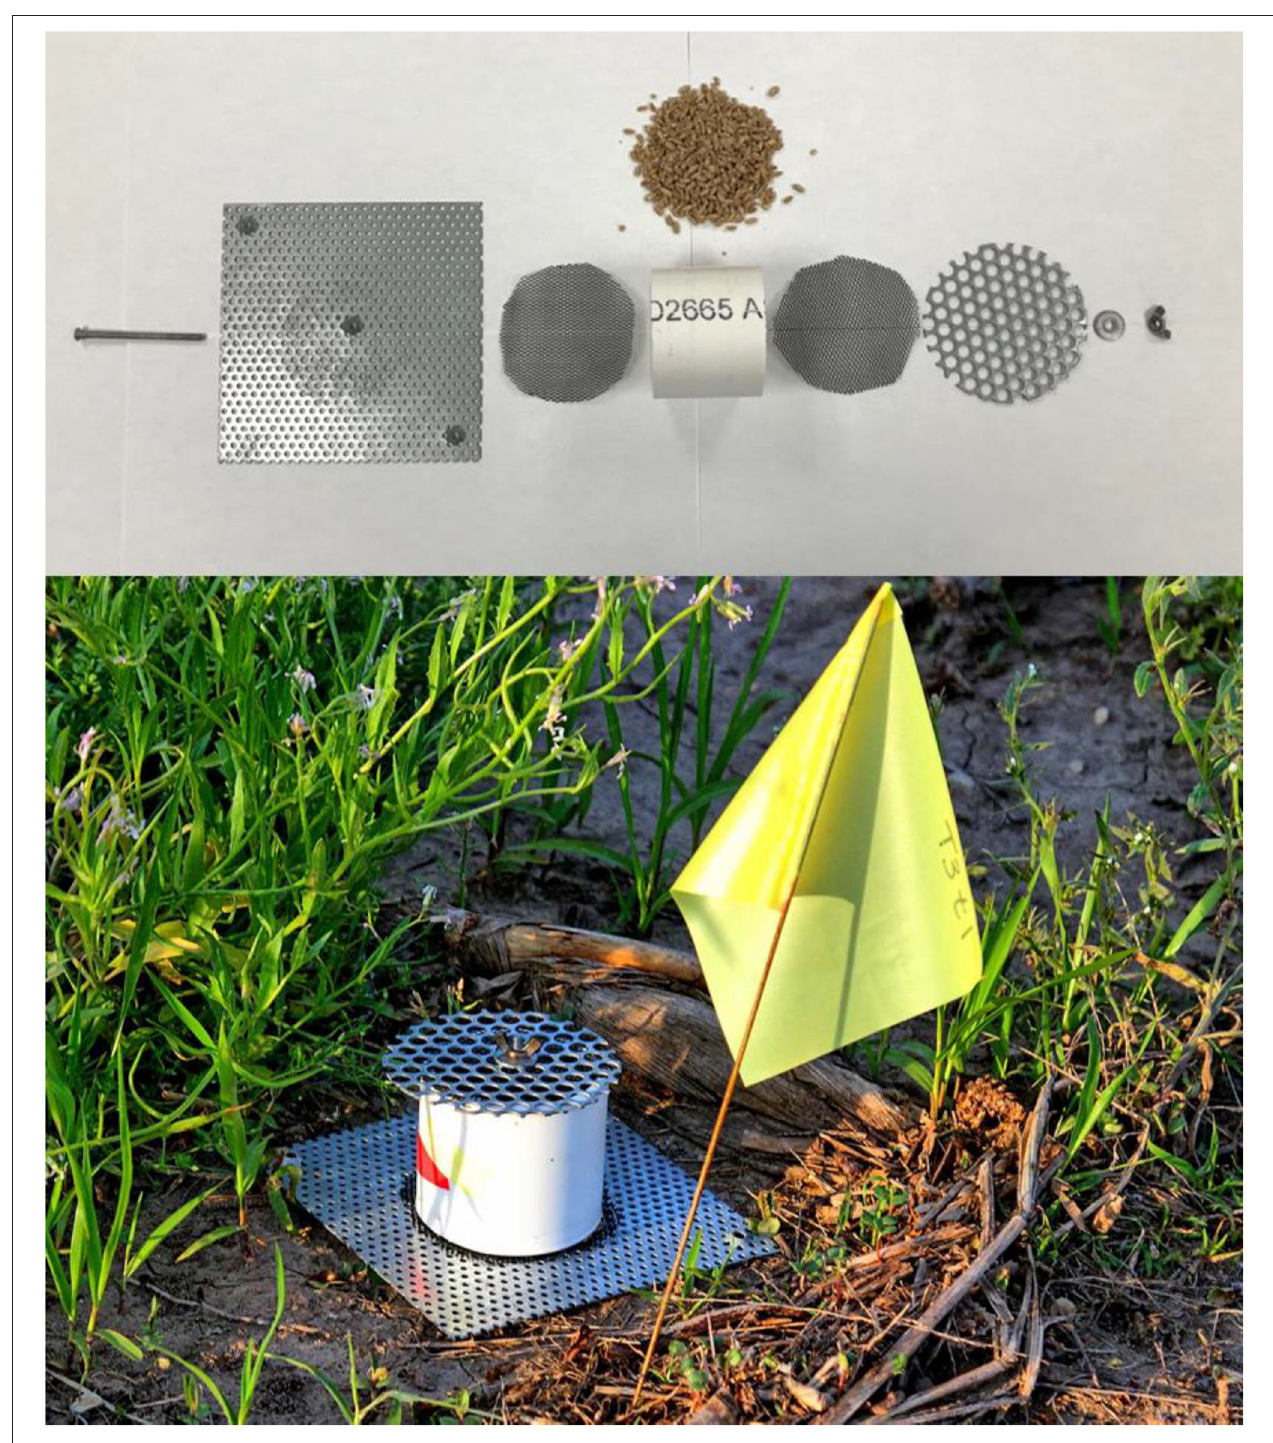
FIGURE 1 | Exploded-view picture of interception traps (top), and field-deployed interception trap (bottom). In order from left to right, each trap included a screw (to hold all parts together), a bottom perforated metal plate, a piece of netting (control or LLIN), cut PVC pipe holding 60g of whole wheat kernels as kairomone and SPB tab lure, a second piece of netting, a top perforated metal plate, and a washer and wingnut on the end of the screw to tightly hold each piece together (top). Interception trap assembled and deployed in the field (bottom).